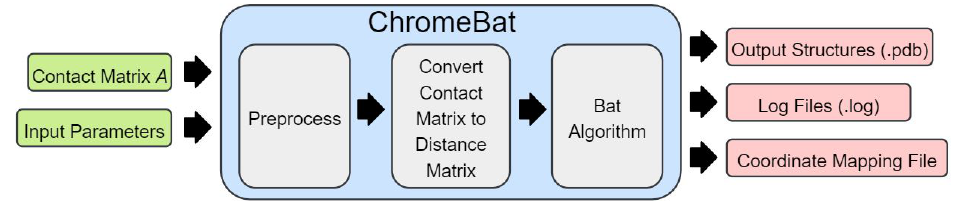
Figure 3. Visualization of ChromeBat’s Pipeline from Contact Matrix to Predicted Structure. Further description of the preprocessing and optimization steps can be found in Sections 2.2 and 2.3,